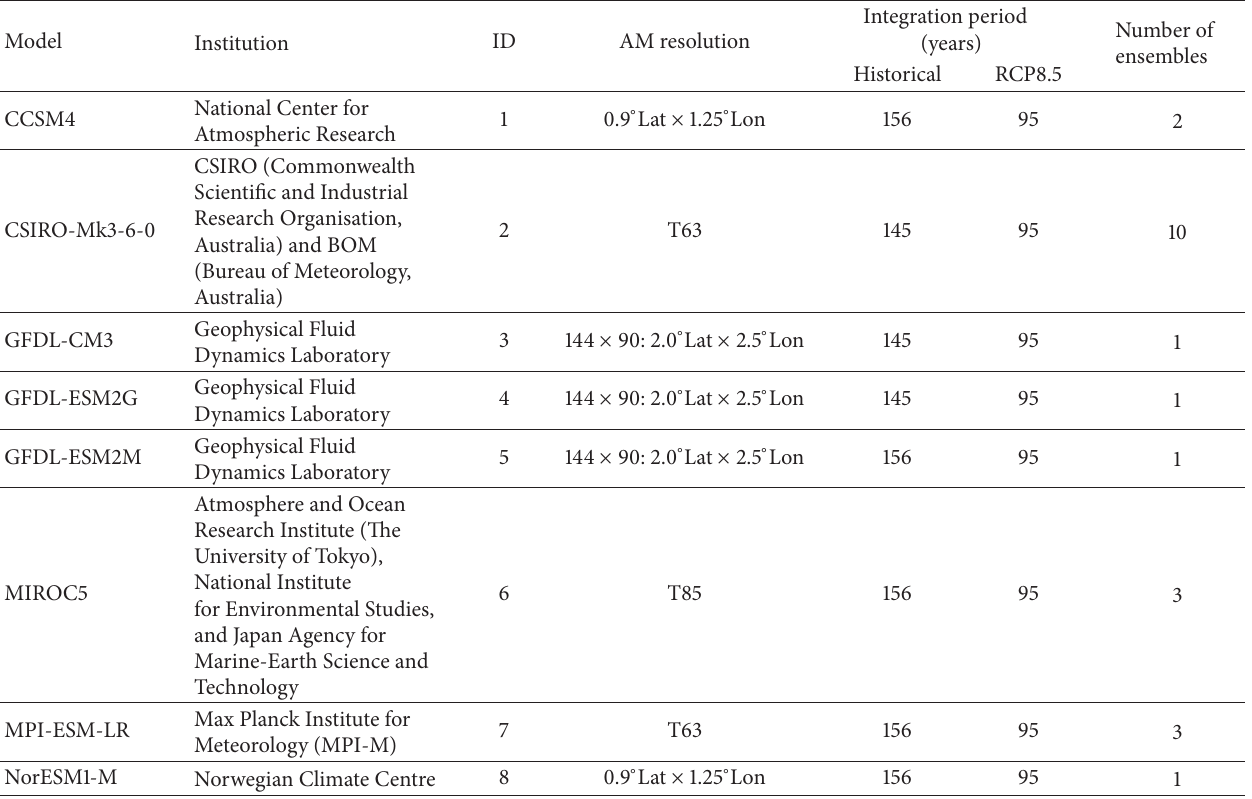
Table 1: CMIP5 model names and